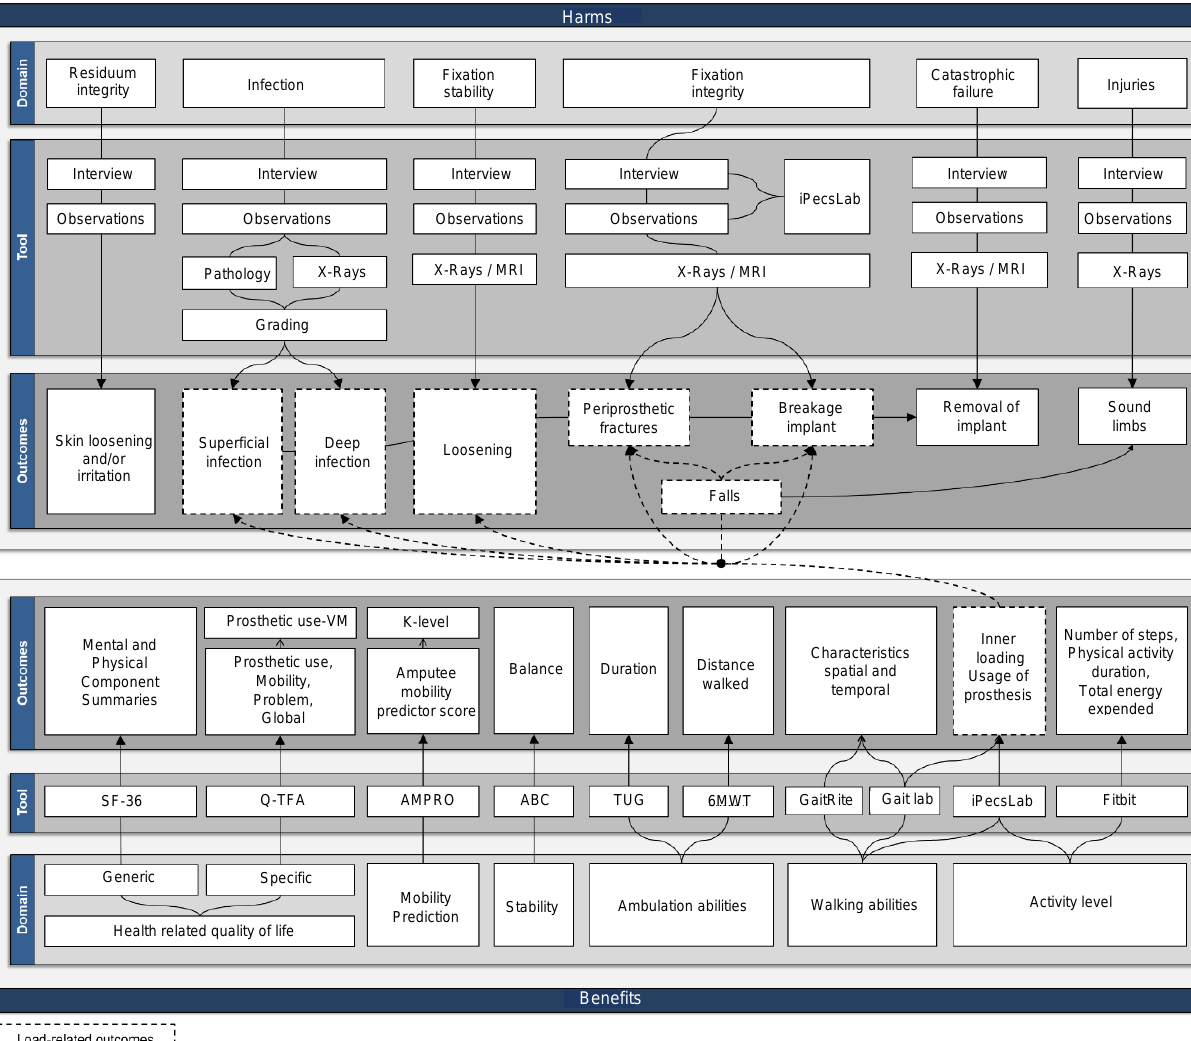
(i.e., 1,598 vouchers) and transtibial (i.e., 242 vouchers) BAPs. 16,18